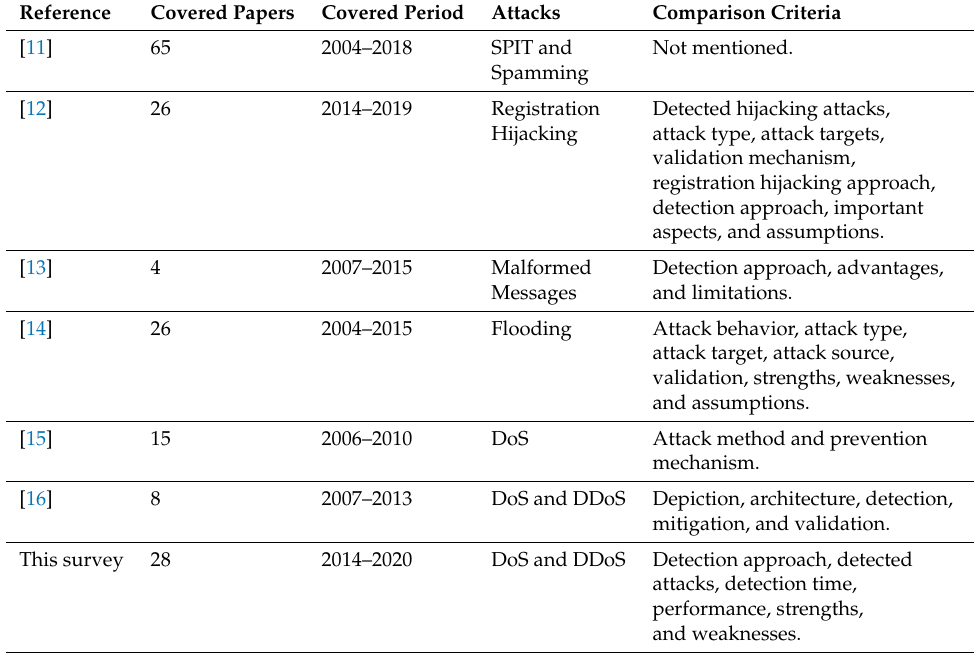
Table 1. Comparison between our survey and recent surveys. SPIT, spam over Internet telephony.